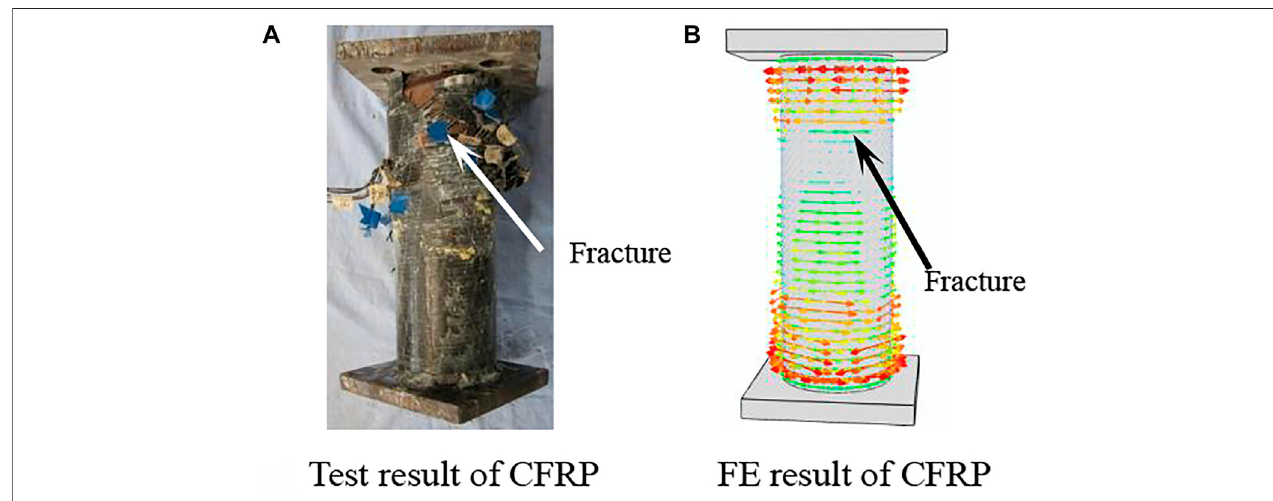
FIGURE 16 | Failure mode of the steel tube of the compression torsion